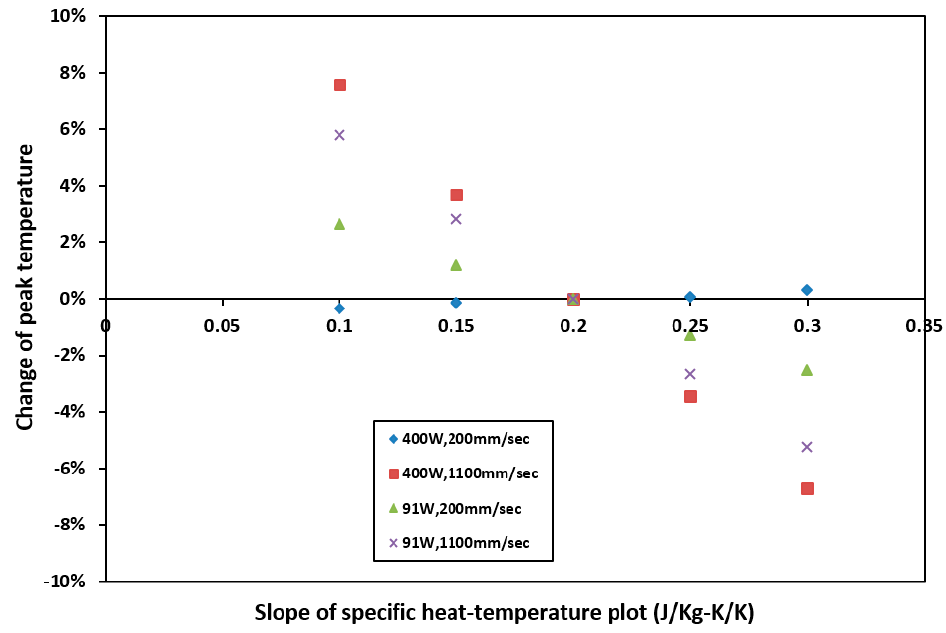
Figure 14. Sensitivity of peak temperature to specific heat. Percentage change of peak temperature with respect to that calculated with base specific heat at different process parameters .